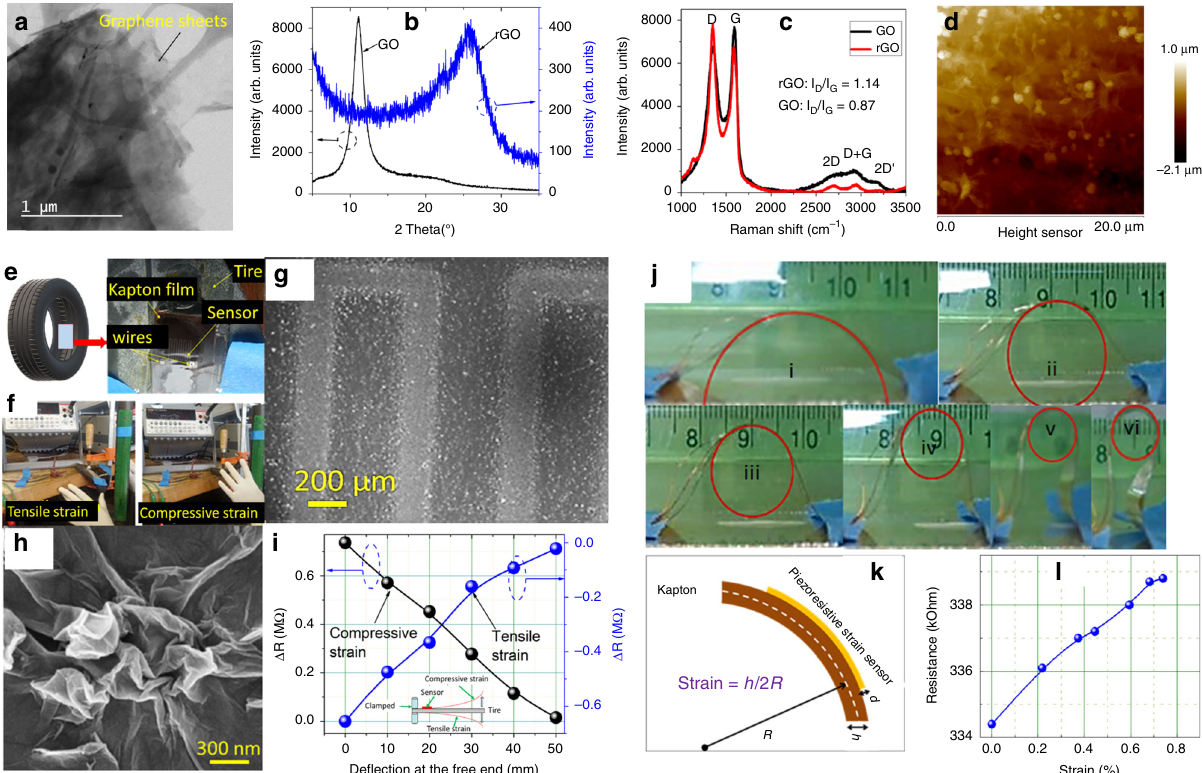
Fig. 2 3D printed sensor characterization. a Bright fi eld TEM images of GO sheets used for 3D printing. To increase conductivity for sensor sensitivity, these GO sheets were reduced chemically after printing. b , c XRD and Raman spectra of GO and rGO delineating structural differences between GO and rGO. d AFM images (20 μ m × 20 μ m) of the 3D printed rGO surface without any major roughness issue. The height scale is given adjacent to d . e 3D printed graphene-based piezoresistive sensor on a piece of tire. The tire image courtesy of Free3D. f Lab measurement setup for measuring change is resistance under tensile and compressive strain. g, h The microstructure of the 3D printed graphene sensor. Please note wrinkled microstructure of graphene sheets, which allows high fl exibility. i Change in resistance under compressive and tensile strain. j Bending of the strain sensor printed on Kapton with different radius of curvatures. The red circles are drawn to overlap the curvature of Kapton due to bending in j . These circles also act as a guide to eyes. k Schematic showing strain measurement from bending. l Resistance versus strain plot from the bending of the